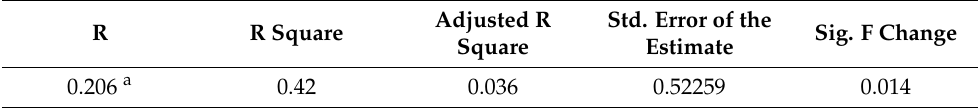
Table 8. Test Significance of Multiple Linear Regression